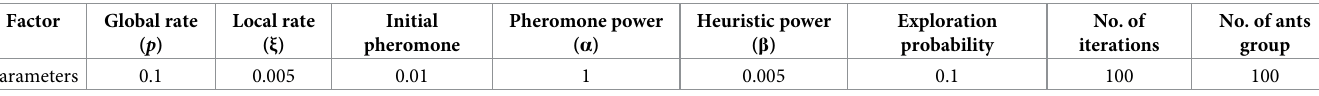
Table 4. Parameter default